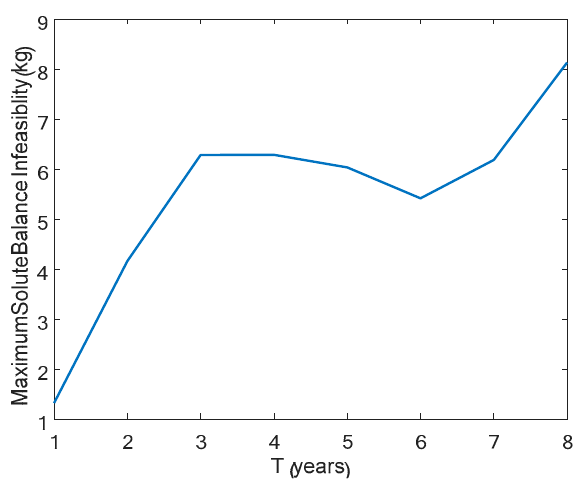
Figure 11. Maximum infeasibility using the SOH.5. Conclusions.